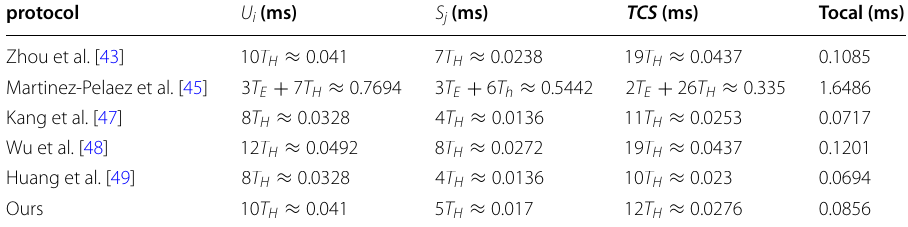
Table 6 The comparisons of computational costs